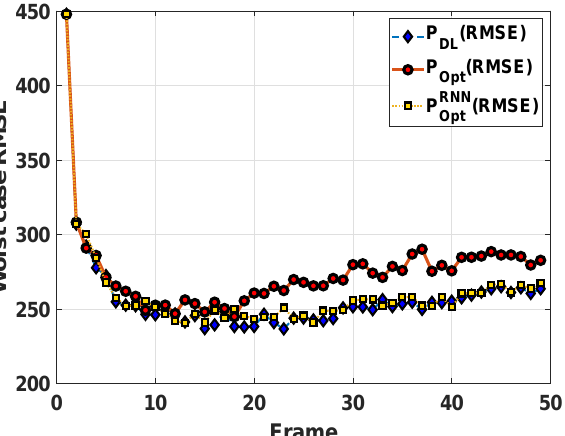
Figure 8. Worst case RMSEs achieved by the optimization-based method based on the prior represen- tation derived by the prediction network.